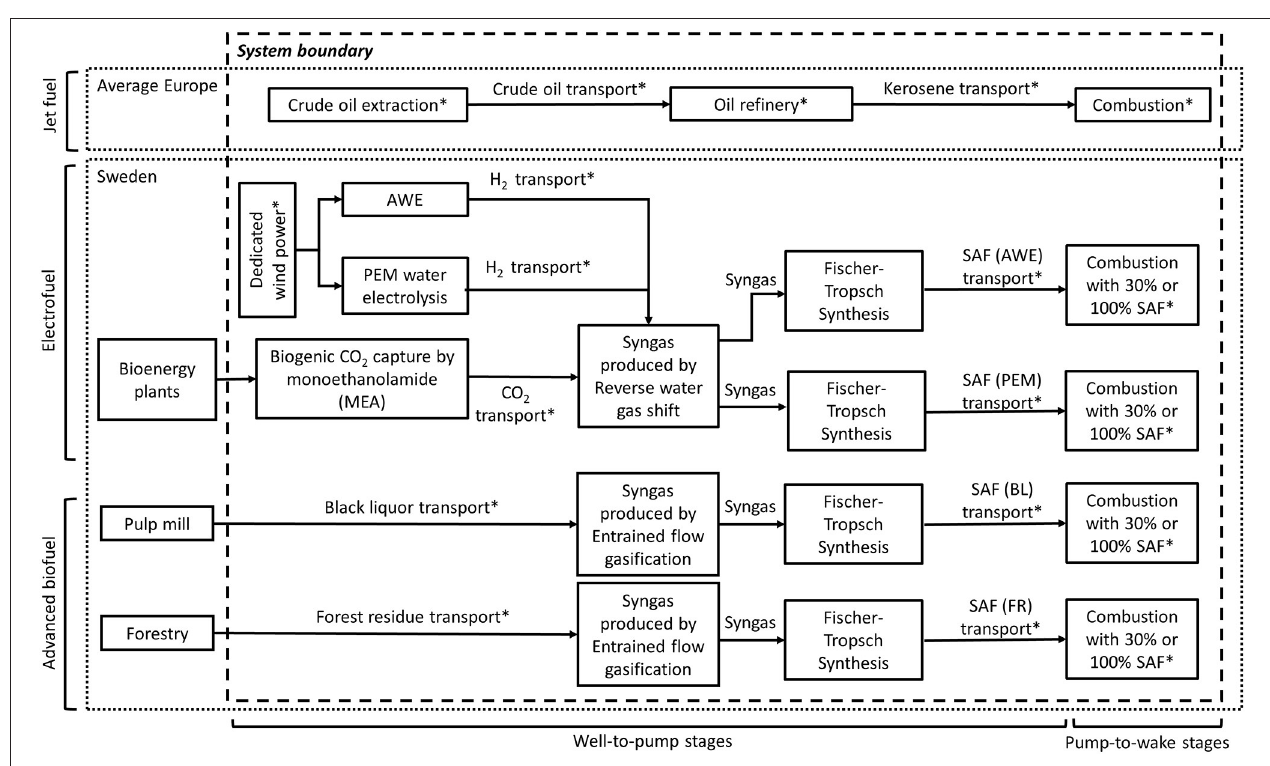
FIGURE 4 | Possible technology pathways for SAF and jet fuel in a scenario for Sweden in 2030. Except for processes marked with * and energy inputs that are not shown in the figure, all processes within the system boundary belong to the foreground system. AWE, alkaline water electrolysis; PEM, polymer electrolyte membrane; BL, black liquor; FR, forest